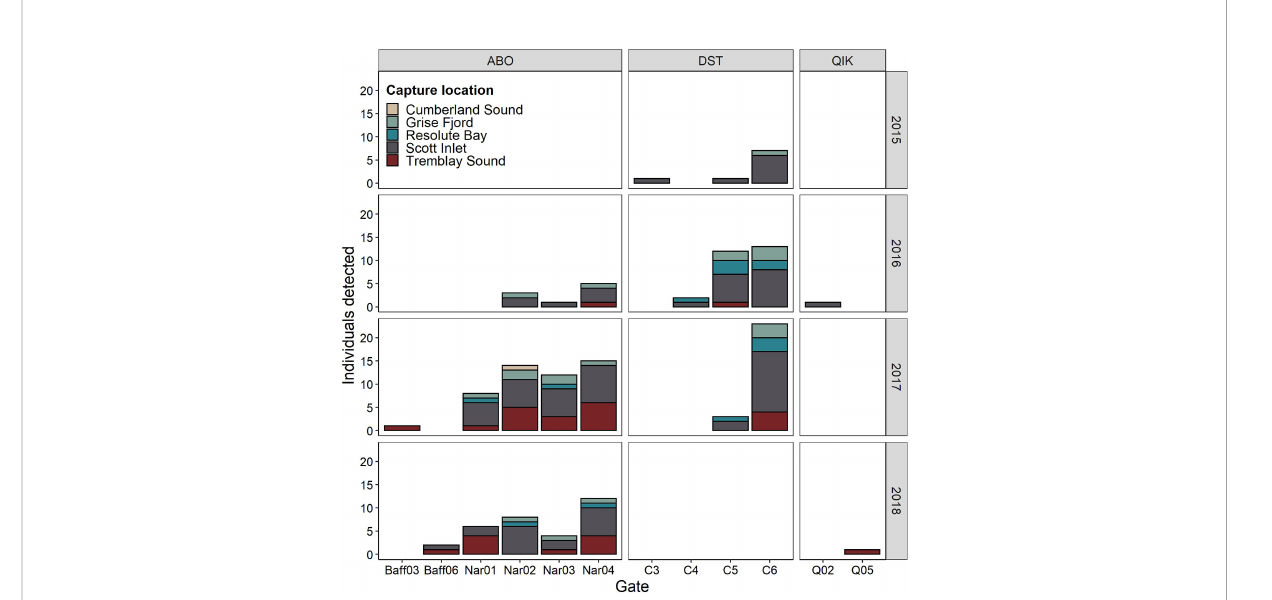
FIGURE 6 Total number of tagged Greenland sharks detected by offshore acoustic receiver stations listed by receiver gate and grouped by array (ABO, DST, and QIK). Bar colour denotes the capture locations of detected individuals. [Colour